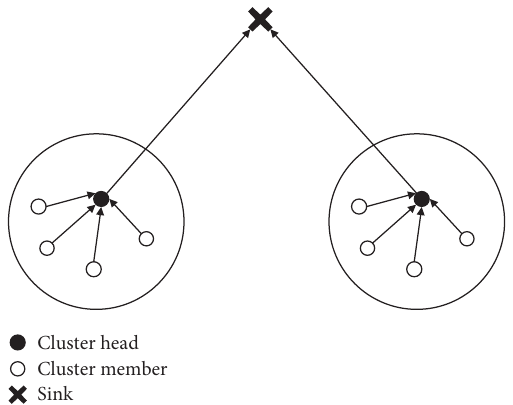
Figure 1: The hierarchical model of the LEACH